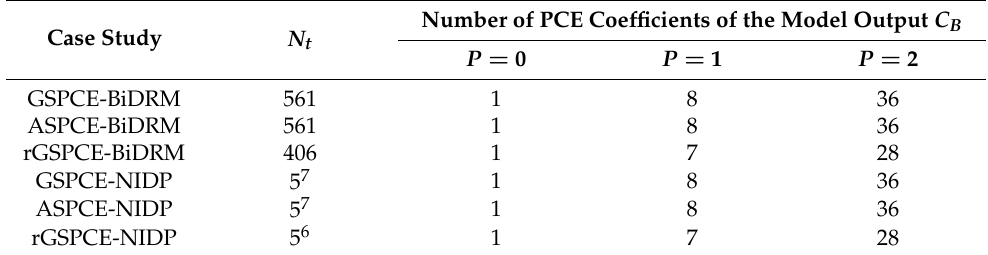
Figure 9. Comparison of the average relative error of the variance for C B for with different ( a ) BiDRM- and ( b ) NIDP-based PCE approaches. Table 9. Summary of the number of PCE coefficients and the number of evaluations in Example 3.